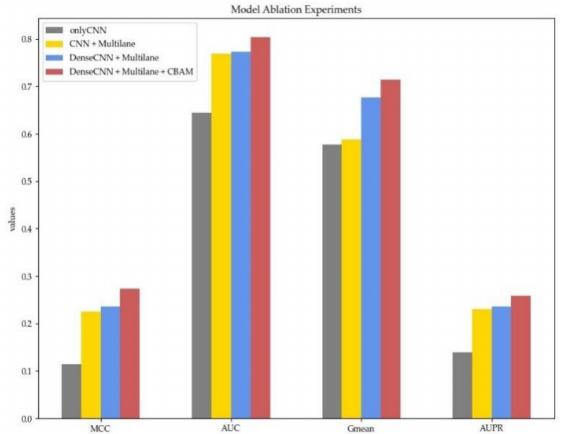
Figure 6. The 10-fold cross-validation performance with different model architectures. Different colors represent different model configurations. Red denotes our proposed